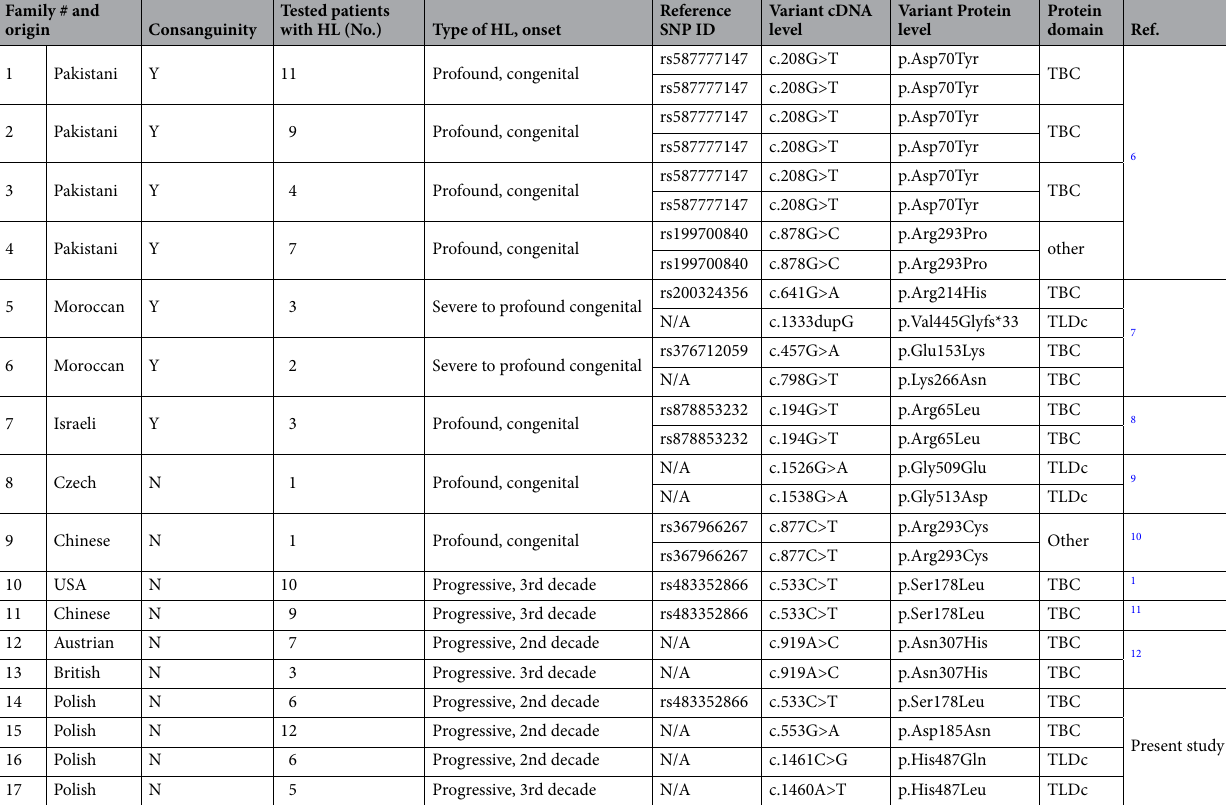
Table 3. Comparison of demographic, molecular, and clinical findings in patients with isolated HL due to TBC1D24 pathogenic variants. HL hearing loss, N no, N/A no data available, Y